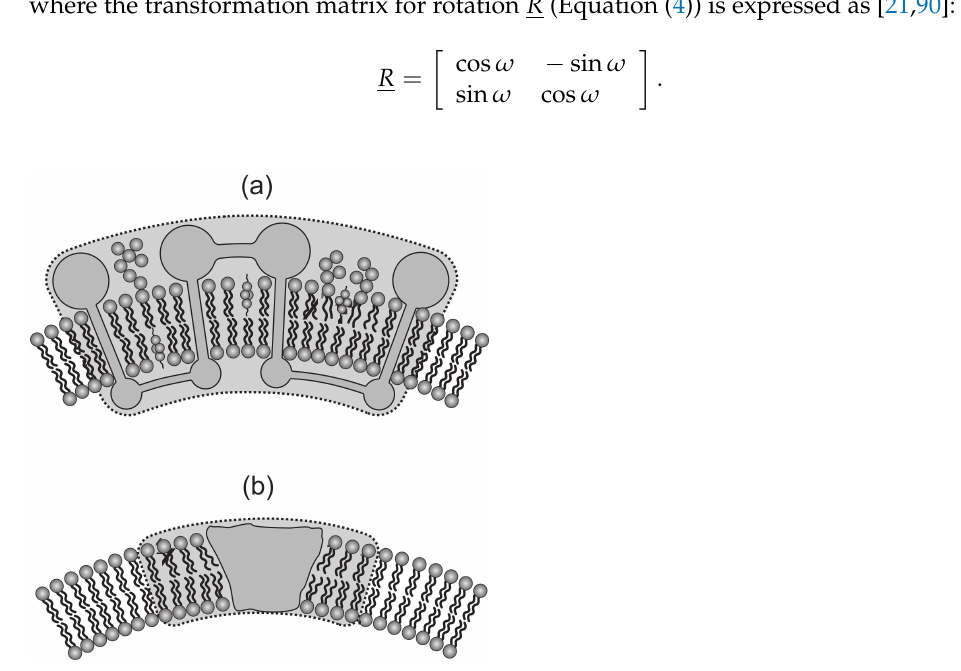
Figure 6. Schematic presentation of flexible membrane nanodomains (consisting of proteins and lipids), which are denoted by shaded area. Panel ( a ) shows a flexible membrane nanodomain including a flexible chain-like protein [26], while panel ( b ) shows a flexible membrane nanodomain formed by a membrane-embedded rigid protein